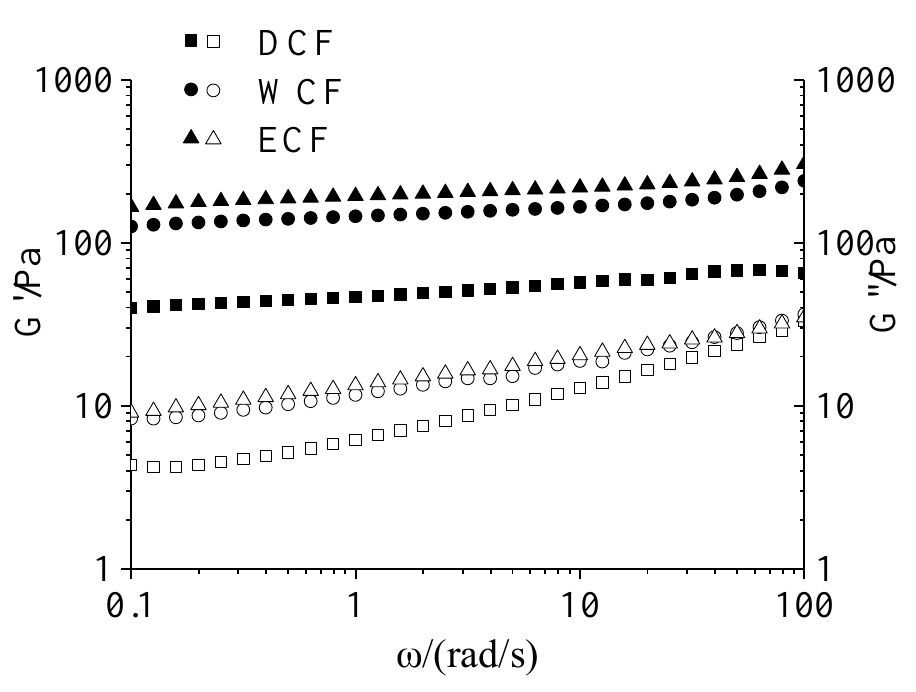
Figure 4. Frequency sweep of corn flour gel. DCF: dry-milling corn flour; WCF: wet-milling corn flour; ECF: enzymatic wet-milling corn flour. Storage modulus G′ ( ■ , ▲ , ●), loss modulus G″ (□ , △ , ○ ).